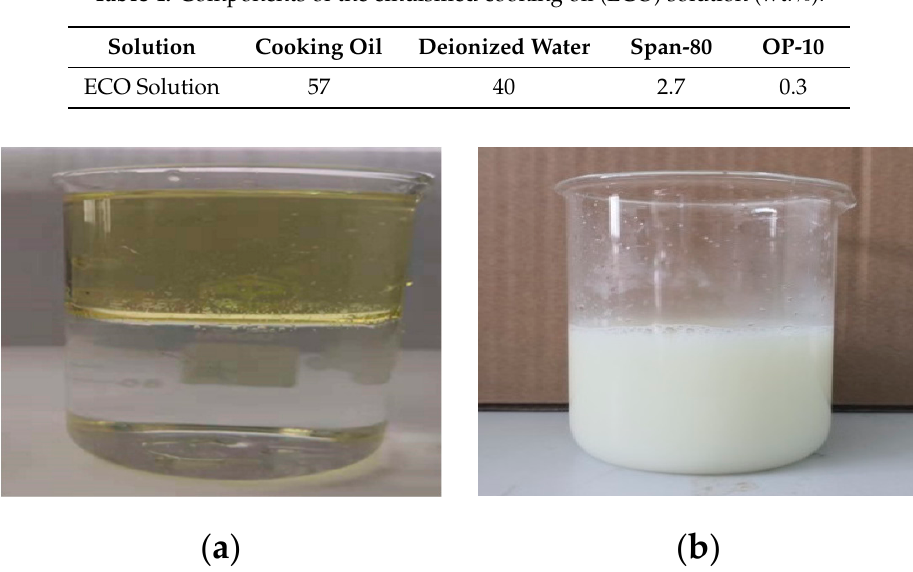
Table 4. Components of the emulsified cooking oil (ECO) solution (wt.%).